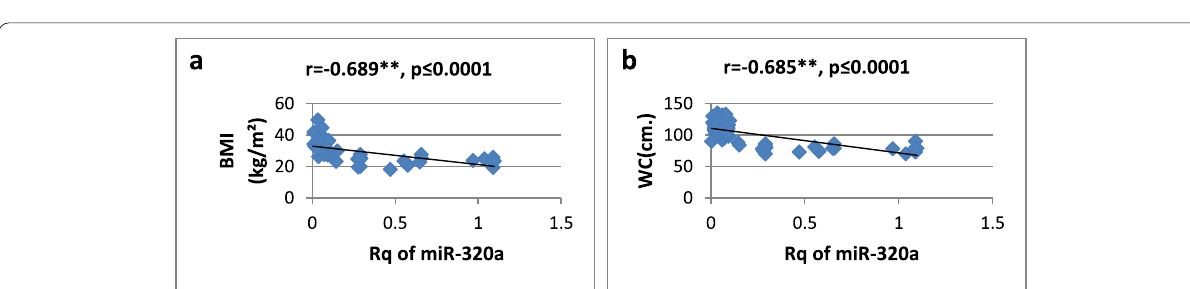
Fig. 7 a , b Correlation coefficient between Rq of MicroRNA 320‑a and both BMI ( r p 0.0001 ≤